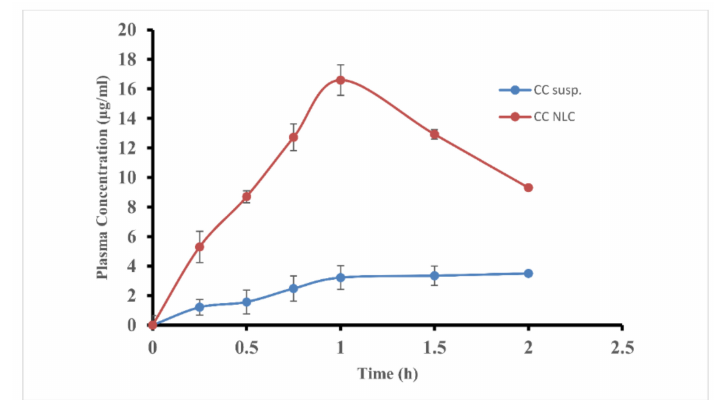
Figure 6. The average plasma concentration of candesartan in rats after intraduodenal administration of CC-NLC and CC